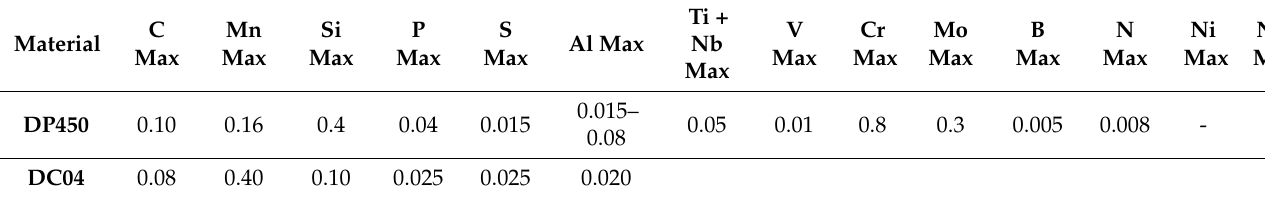
Table 4. Steels chemical compositions (%at.).